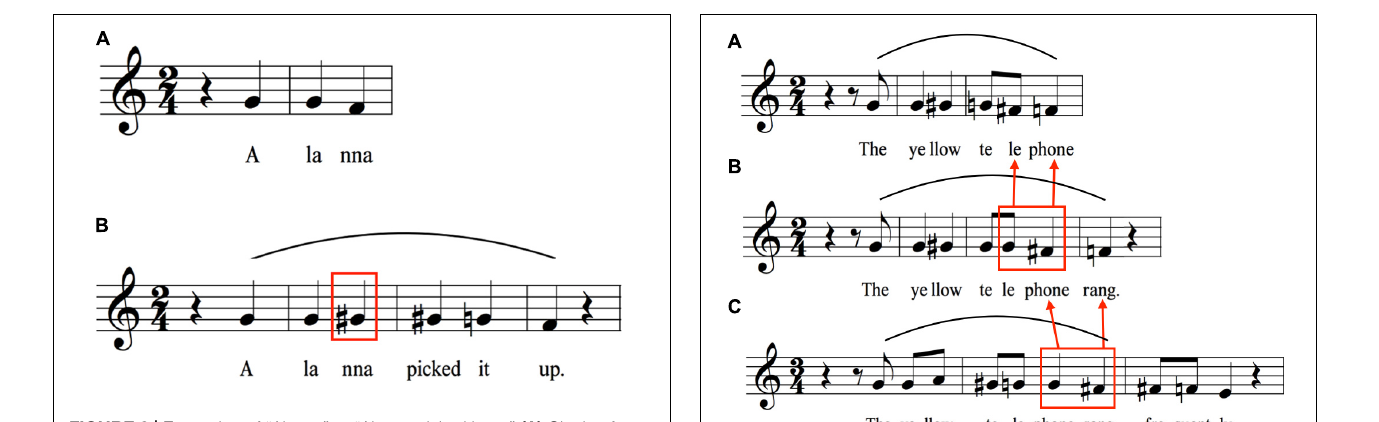
FIGURE 3 | Expansion of “Alanna” to “Alanna picked it up.” (A) Citation form of “Alanna.” (B) Expansion to create the sentence “Alanna picked it up.” Notice the contour reversal for “nna” (red box) compared to the citation form in (A) .